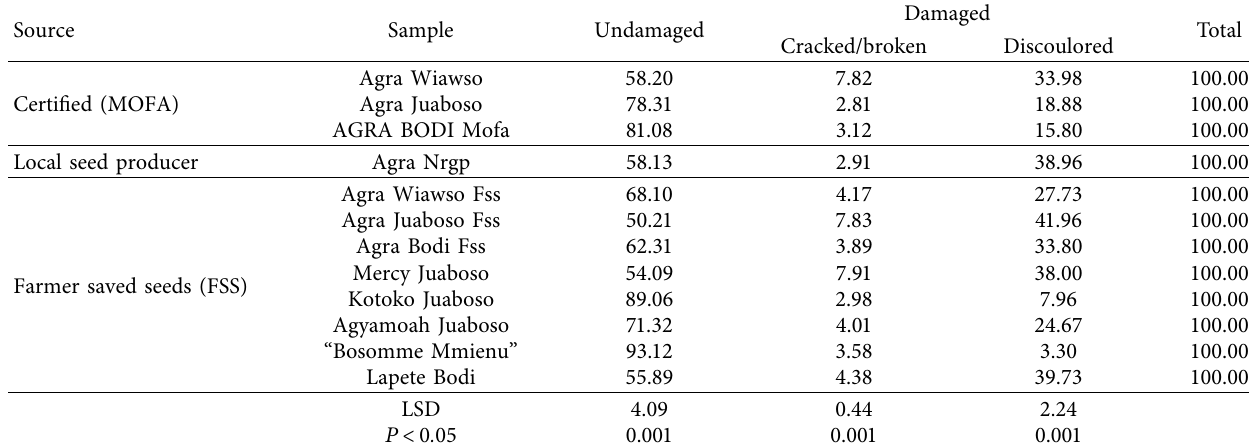
Table 3: Categories of seed types and their percentages collected from three